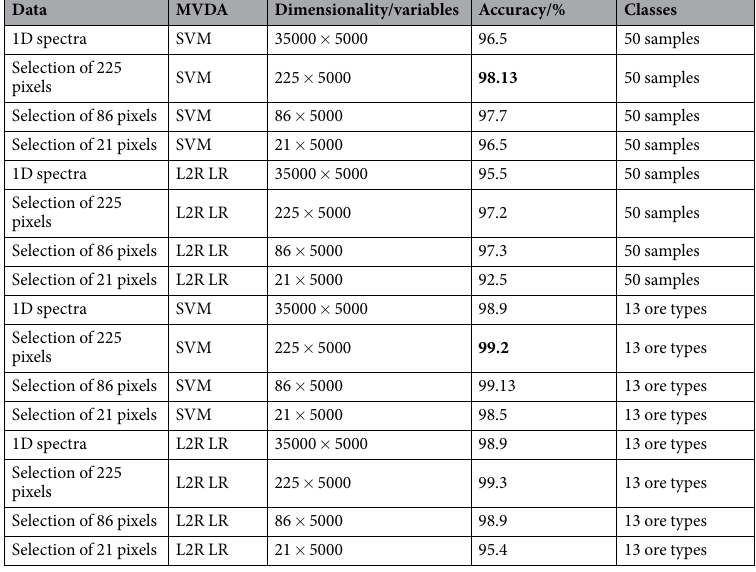
Table 1. Classification results of sedimentary ores using linear (L2R LR) and non-linear (SVM) MVDA algorithms. Prior to classification, the data set was distributed into 50 classes according to individual samples and then according to respective ore type. The selection of pixels was provided from the echellograms as described in detail in the text. The best results yielded during the classification process are in